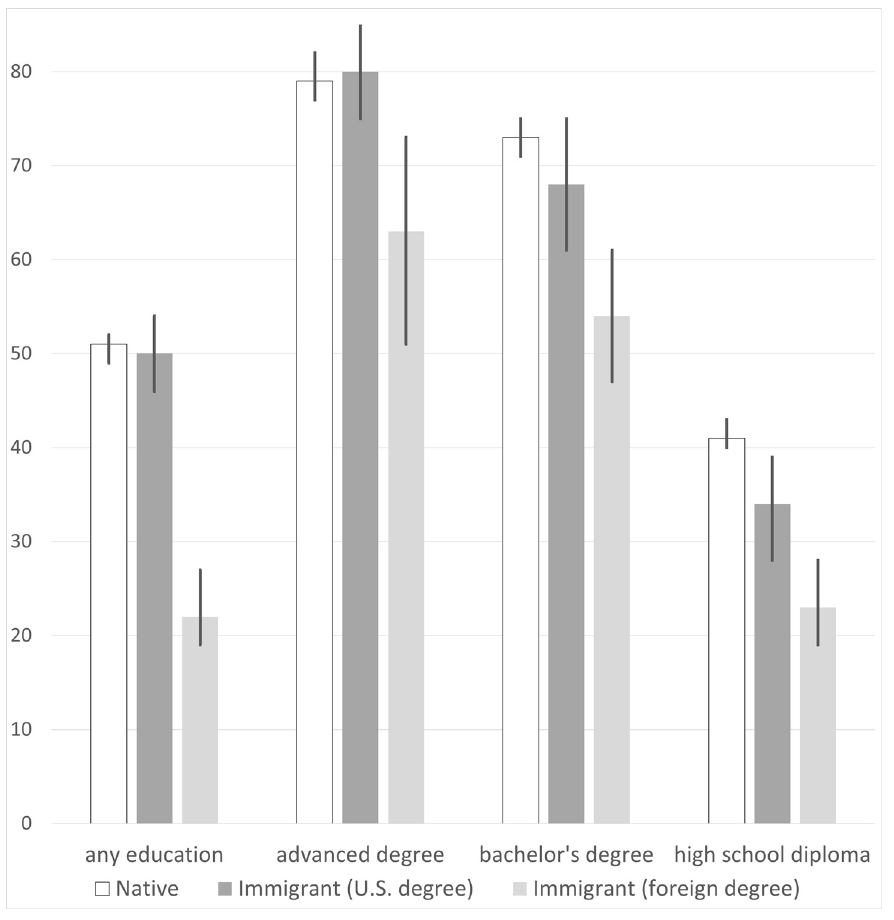
Fig 2. Average percentile scores on PIAAC numeracy, by immigrant-education group. The vertical line at the top of each bar indicates the 95% confidence interval. The scores are not age-adjusted.